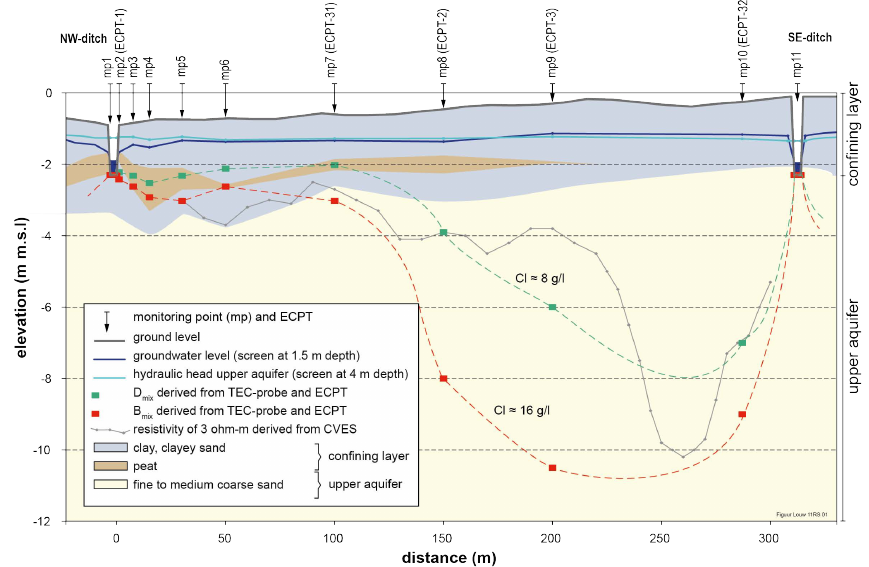
Fig. 9. Cross-section of site 11 with the measured hydraulic head at 1.5m and 4m depth (on 21 January 2010), D mix and B mix derived from TEC-probe and ECPT, and the real inverted soil resistivity isoline of 3 (cid:127) m derived from CVES measurements. Note that the CVES-line was situated about 60m from the 1-D measurements (Fig. 4c) and therefore shows a sharper